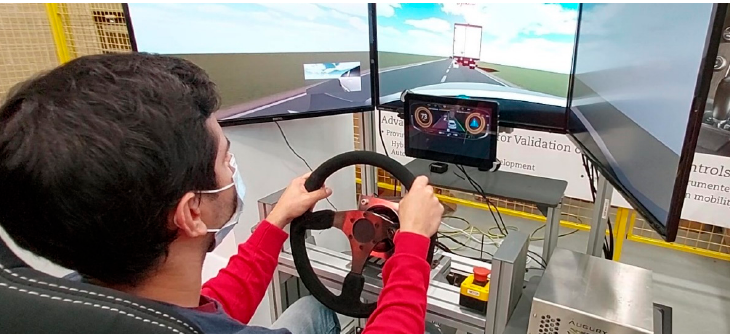
Figure 2. DiL simulator for AD applications with Dynacar vehicle simulation software in screens, and Re:Lab HMI as the instrument